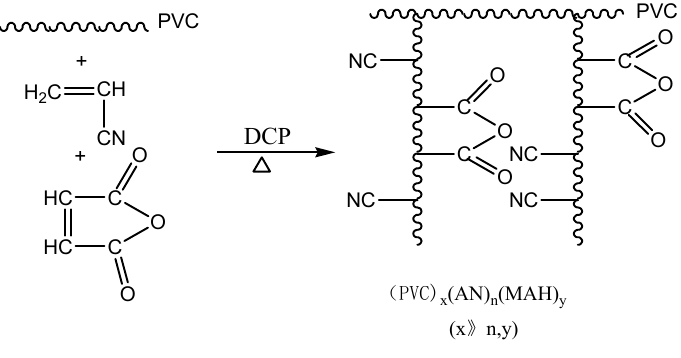
Scheme 2. The schematic diagram of the molded process reaction mechanism of heat resistant cross-linked PVC foam